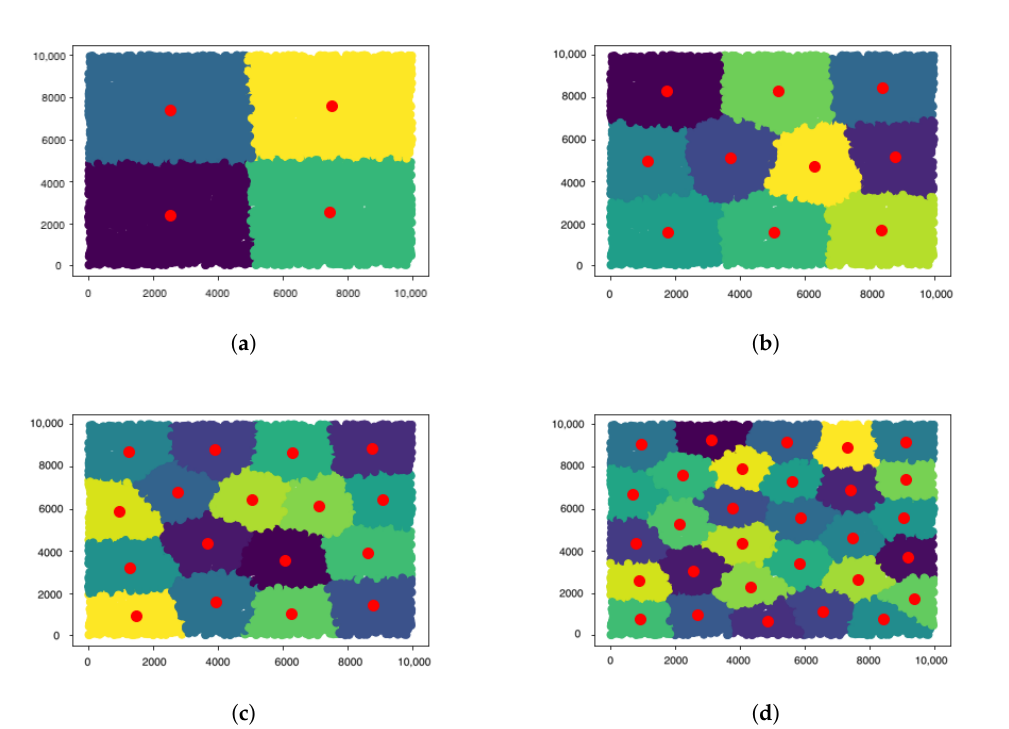
Figure 2. Gateway Clusters ( a ) 4 Gateways, ( b ) 10 Gateways, ( c ) 17 Gateways, and ( d ) 30